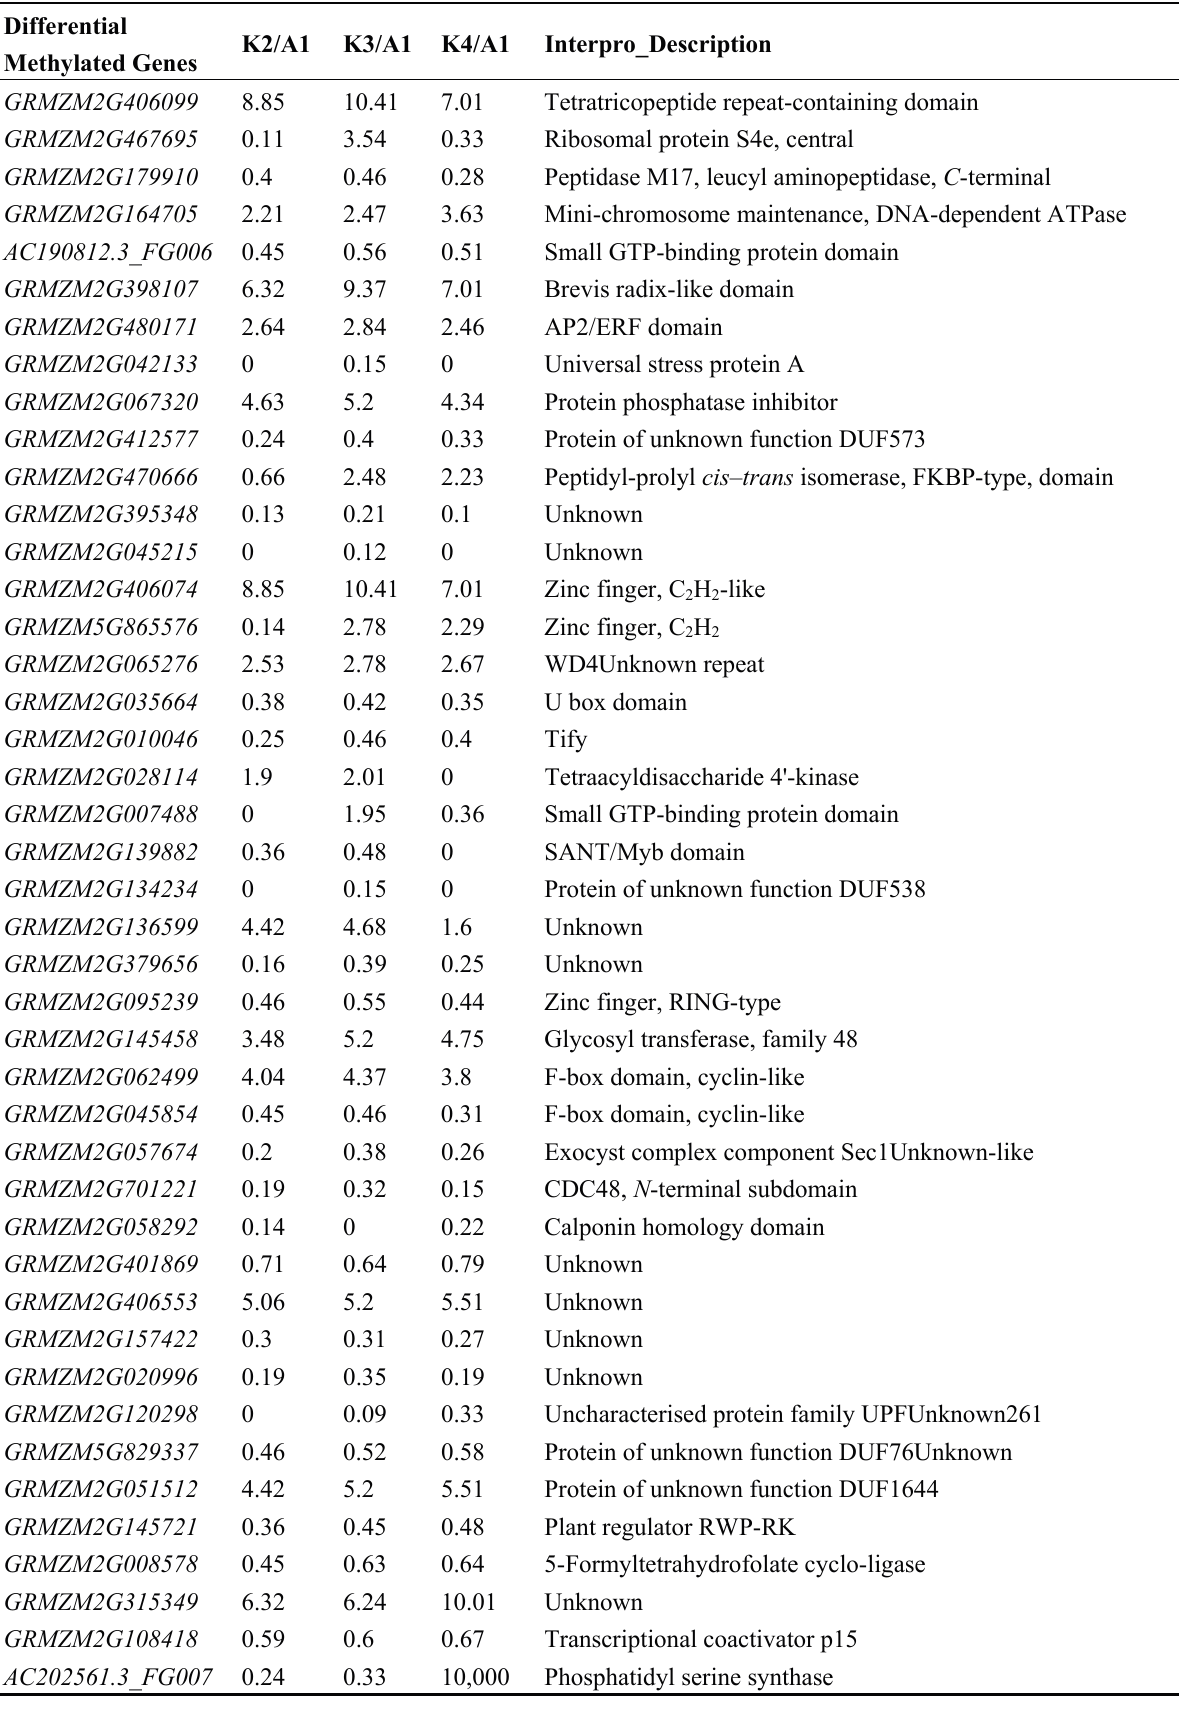
Table 1. Differentially methylated genes shared by K2 versus A1, K3 versus A1, and K4 versus A1. Differential Methylated